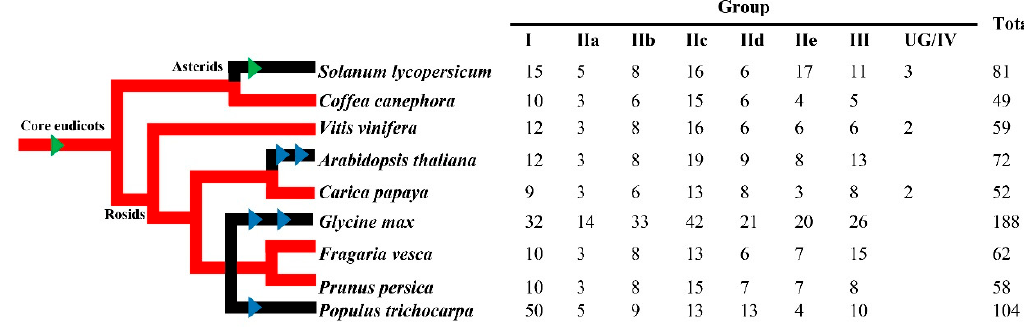
Figure 1. Evolutionary relationships of WRKY genes in C. canephora and other species. UG, ungrouped, indicates the subfamily members from a distinct group in a combined phylogenetic tree. Green arrowheads indicate all genome triplication events. The blue arrowheads show all genome duplication events. The red lines trace lineages of five species that have not undergone further polyploidization. The number of WRKY genes in Solanum lycopersicum , Vitis vinifera , Glycine max , Fragaria vesca , Prunus persica , and Populus trichocarpa were collected from previous studies [8–16,49]. The phylogeny and genome duplication history of core eudicots was also cited from a previous study [34].